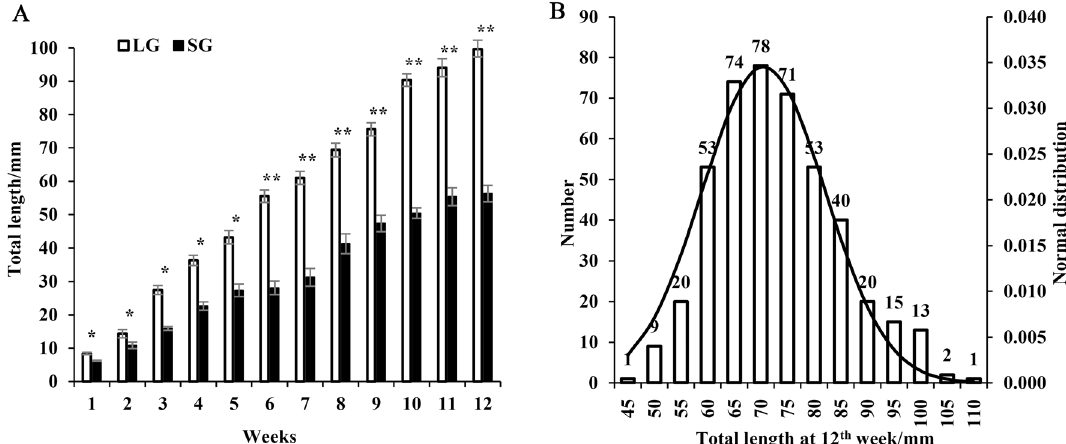
Figure 1. The weekly morphological characteristics (total length) of large-scale loach from large group (LG) and small group (SG). ( A ) The weekly total length of LG and SG loach ( n = 150 fish individuals). ( B ) The normal distribution of loach total length at 12th week ( n = 450 fish individuals). Vertical bars represent mean ± SD; * show the significant difference in total length between LG and SG; * p < 0.05, ** p <